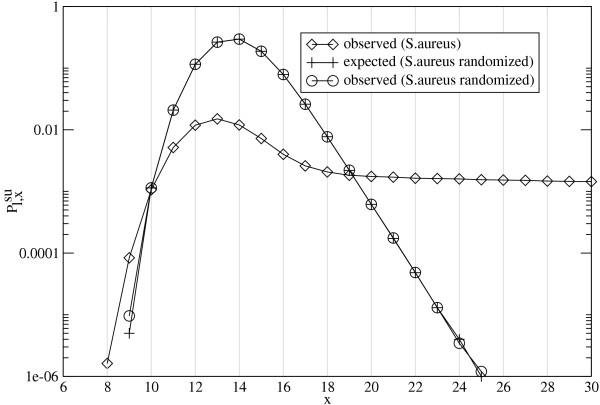
Shustring probability distribution in five randomized strains of Staphylococcus aureus. Observed and expected distributions of the lengths x of local shortest unique substrings. Parameters l = 1.42·107 and 2p = 0.330 correspond to the combined length and average GC-content of five strains of Staphylococcus aureus.